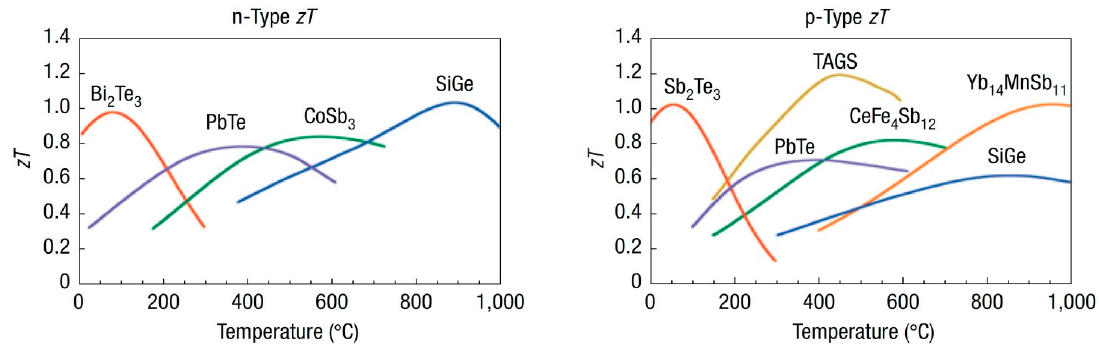
Figure 1. Temperature dependence of the figure-of-merit zT; it is obvious that every material has an own preferred operating temperature [2].